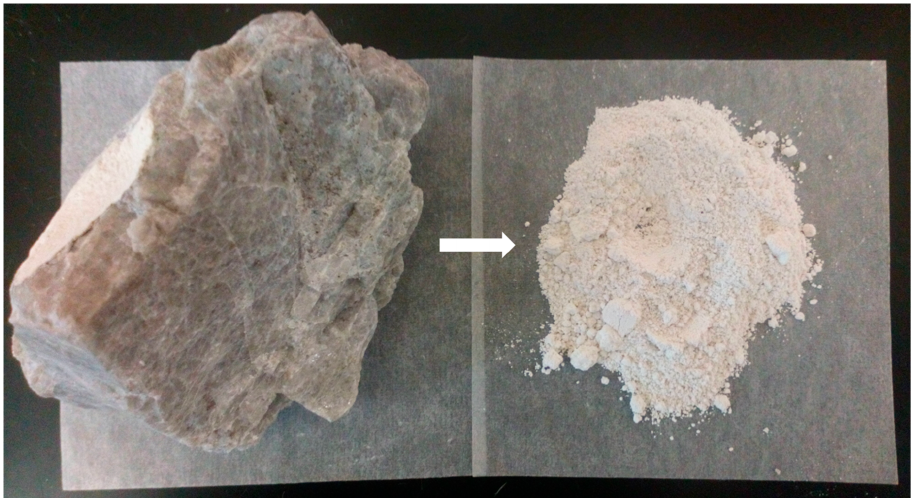
Figure 1. Imergard TM WP before and after processing. Perlite, the active ingredient of Imergard TM WP, is a volcanic rock ( left ) that can be expanded (when heated to 760–980 ◦ C) and then processed (drying and grinding) to obtain the fine white powder used in this study ( right